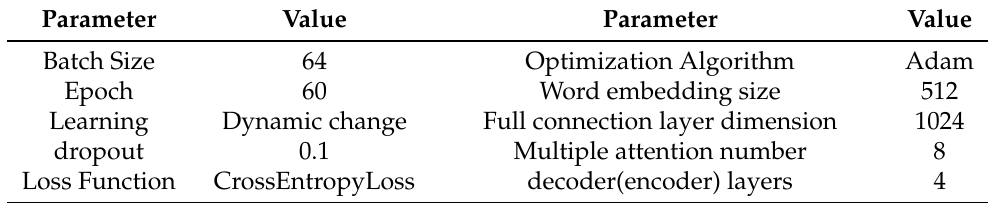
Table 2. Parameter configuration of the